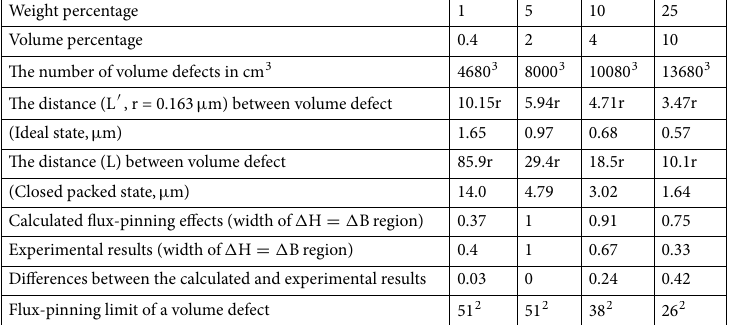
2 which is set as